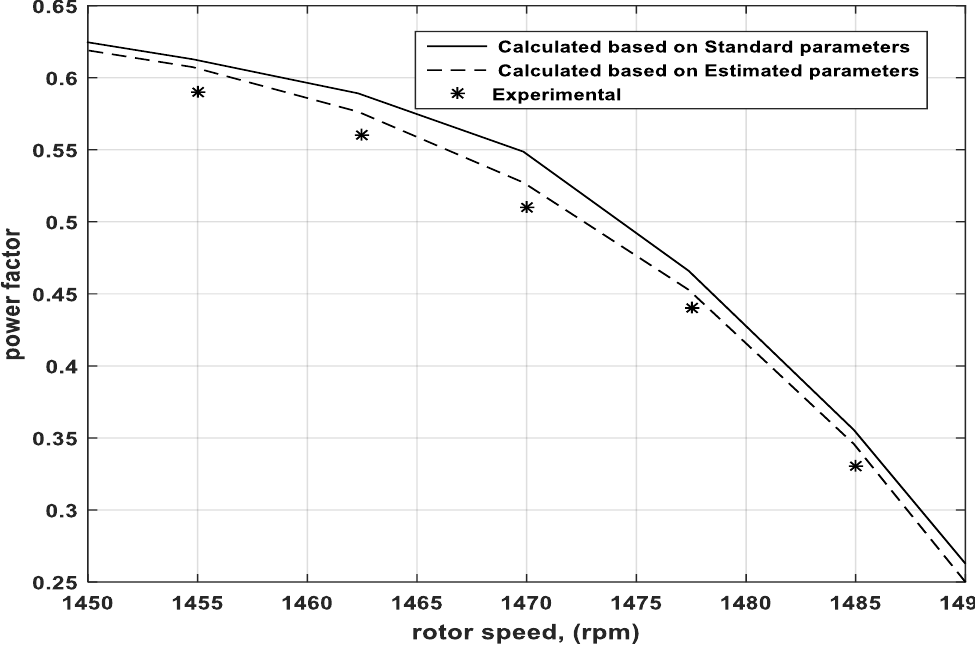
Figure 10. Variation of power factor versus motor speed.